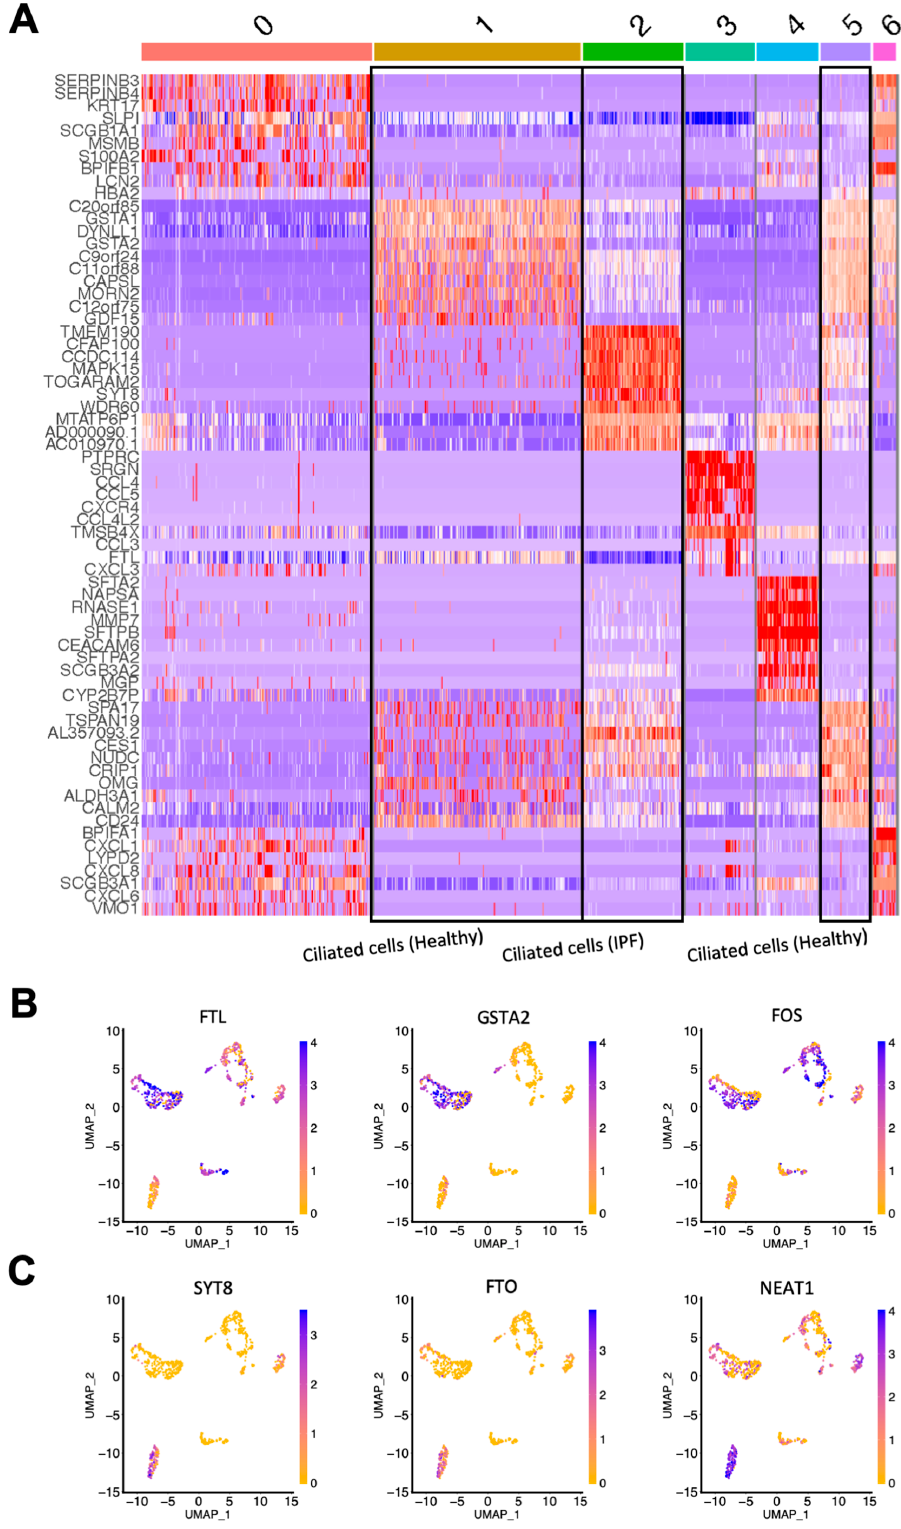
Figure 3. Single-cell gene expression reveals differentially expressed genes in ciliated cells from healthy and IPF tissue. ( A ) Heatmap showing differentially expressed genes in the clusters (0–6; see Figure 2D) identified from the sequencing analysis. ( B ) UMAP plots showing the expression of 3 top upregulated genes in healthy ciliated cells versus IPF ciliated cells. ( C ) UMAP plots showing the expression of 3 top upregulated genes in IPF ciliated cells versus healthy ciliated cells. IPF n = 2, healthy n =